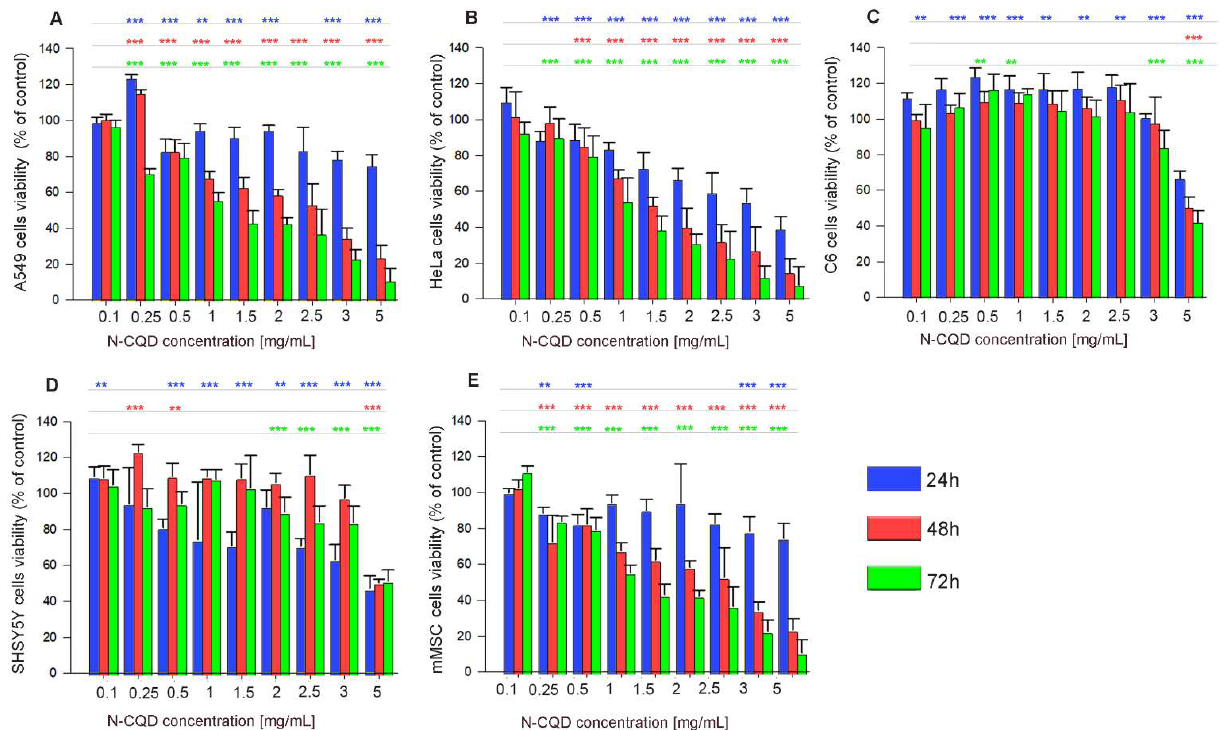
Figure 2. Viability of different cell lines after exposure to growing concentrations of N-CQDs: ( A ) A549, ( B ) HeLa ( C ) C6, ( D ) SH-SY5Y, ( E ) mMSC. All results, including statistical significances, are colored by culture time: 24 h (blue), 48 h (red), and 72 h (green). The statistical significance of the differences is related to control samples and marked on the graphs with asterisks (* for p ≤ 0.05, ** for p ≤ 0.01, *** for p ≤